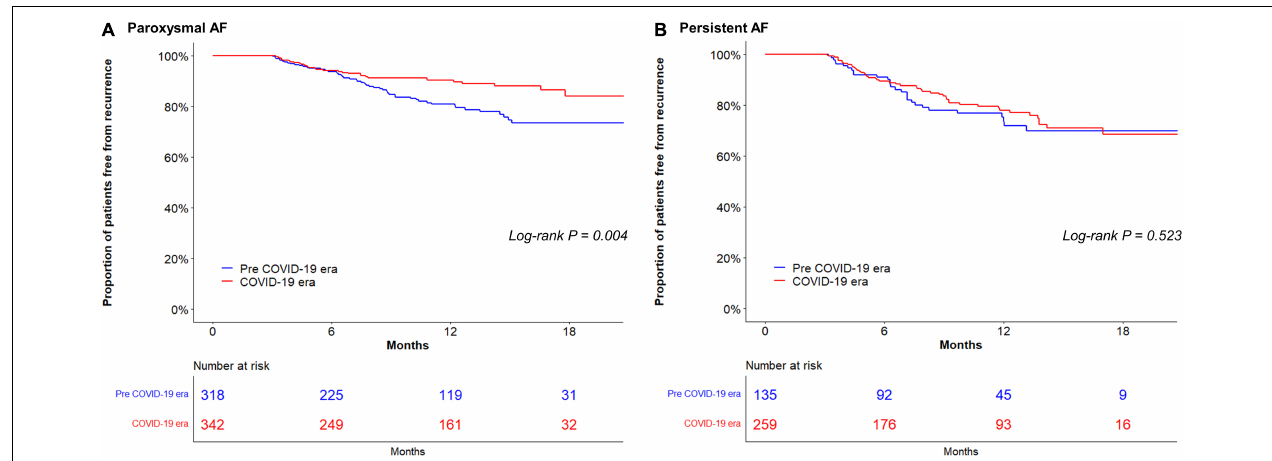
FIGURE 2 | Kaplan–Meier analysis of atrial fibrillation: (AF) recurrence-free survival in paroxysmal AF (A) ; and in persistent AF (B) . AF, atrial fibrillation; COVID-19, coronavirus disease 2019.